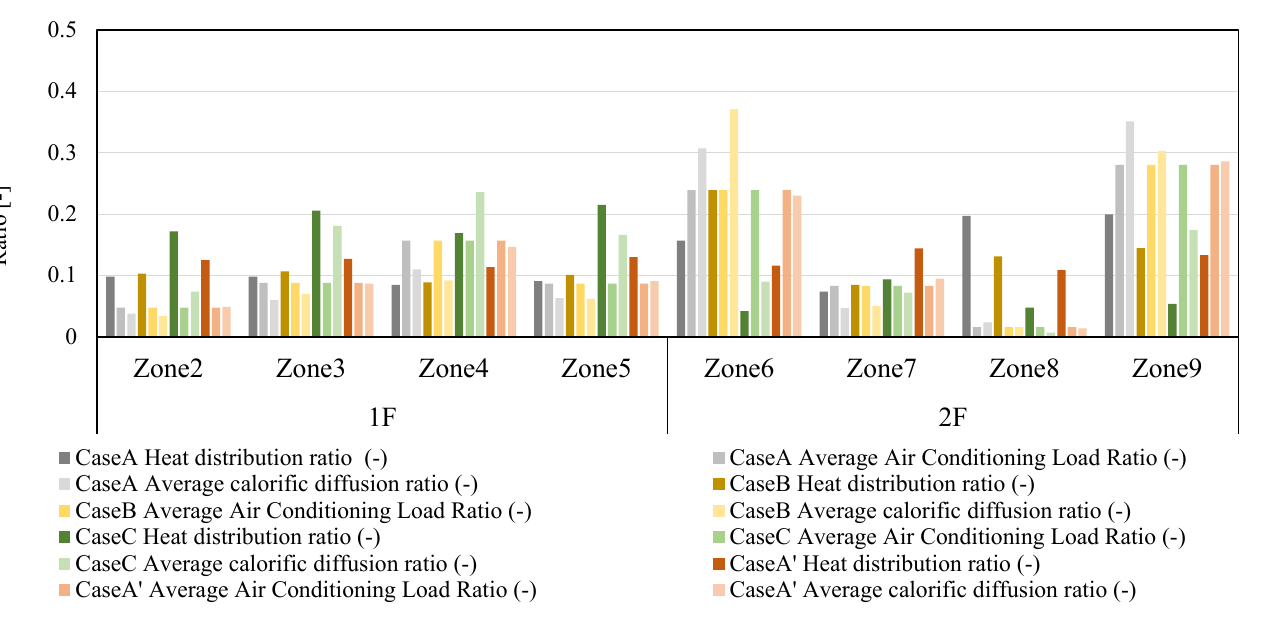
Figure 13. Comparison of heat distribution ratios between cases in summer.